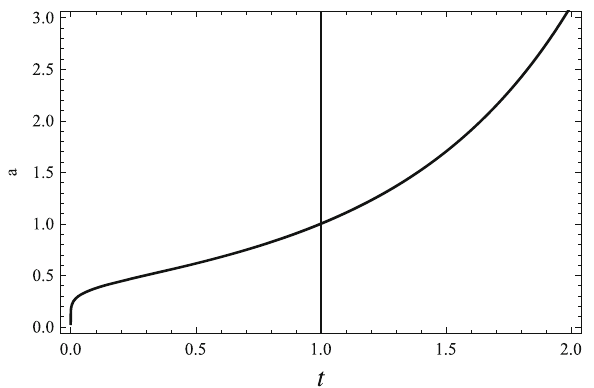
Fig. 2 The variations of the Hubble parameter with respect to the time t for the values of h 0 = 1 and V 0 = 0 . 28. The vertical line shows the present time t 0 = 1